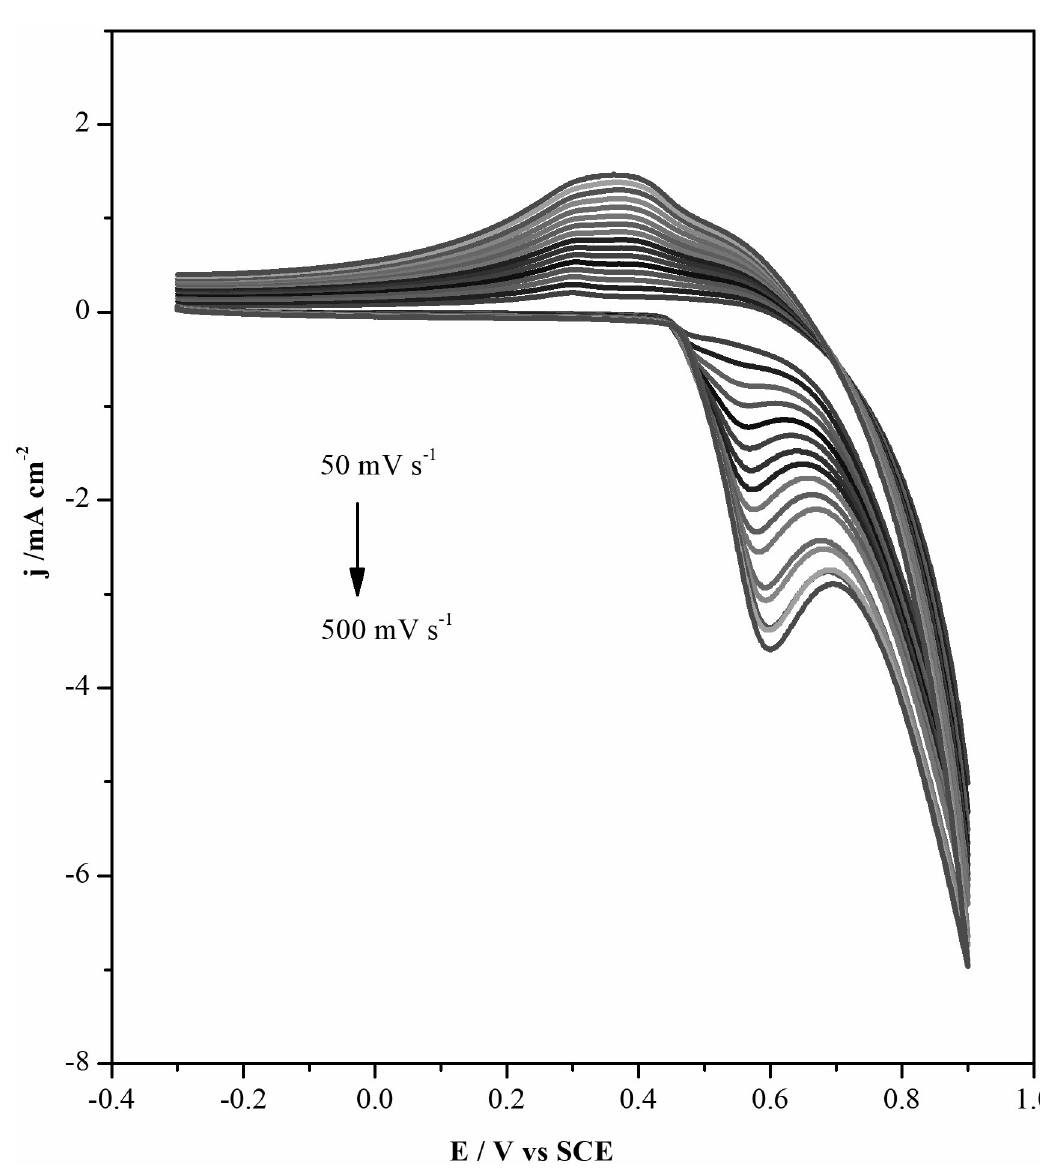
Fig 5. CVs of different scan rates of Cu@Ni CSNPs/N-GQDs/Nafion/GCE in 0.1 M NaOH containing 10 μ M glucose.